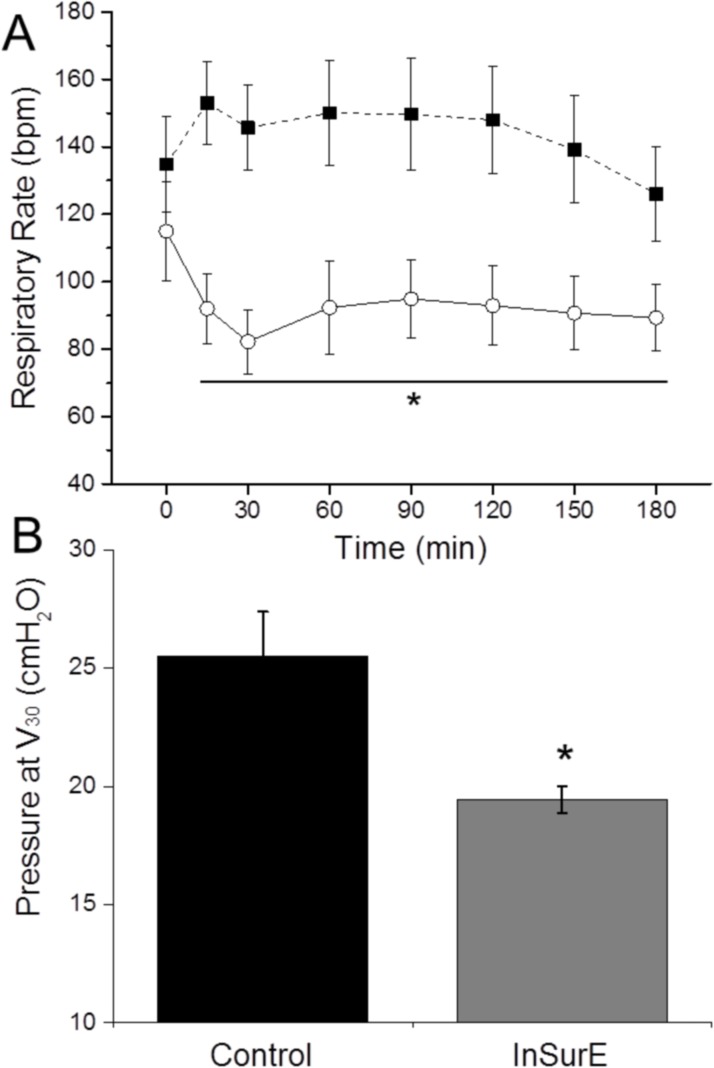
Respiratory parameters of surfactant-depleted rabbits.(A) Mean respiratory rate values of the animals managed just with nasal CPAP for 180 min (solid squares) and of the animals treated with 200 mg/kg of surfactant following the InsSurE approach and managed further for 180 min in nasal CPAP (empty circles). (B) Mean pressure values recorded after insufflating 30 ml of air post mortem (V30) in the lungs of the animals managed just with nasal CPAP (control) and of the animals treated with 200 mg/kg of surfactant following the InSurE approach and managed further for 180 min in nasal CPAP are shown.). N = 6 and N = 9 in the Control and InSurE groups, respectively. * P vs. Control < 0.05.